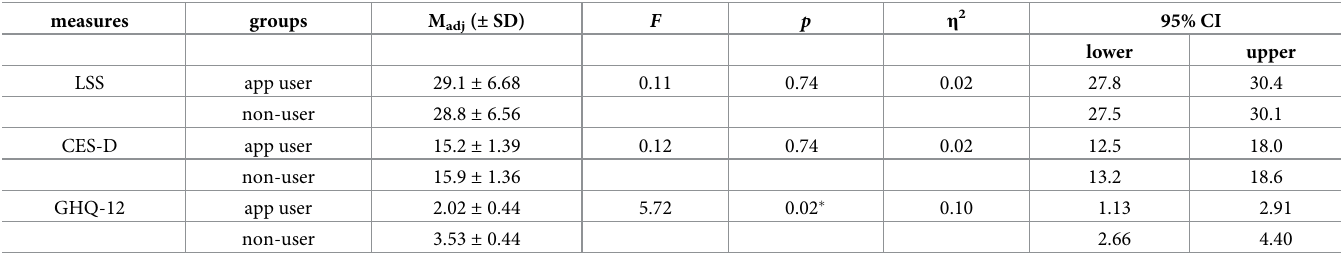
Table 4. Comparison of app user and non-user group using ANCOVAs in post-test with pre-test as covariates. measures groups